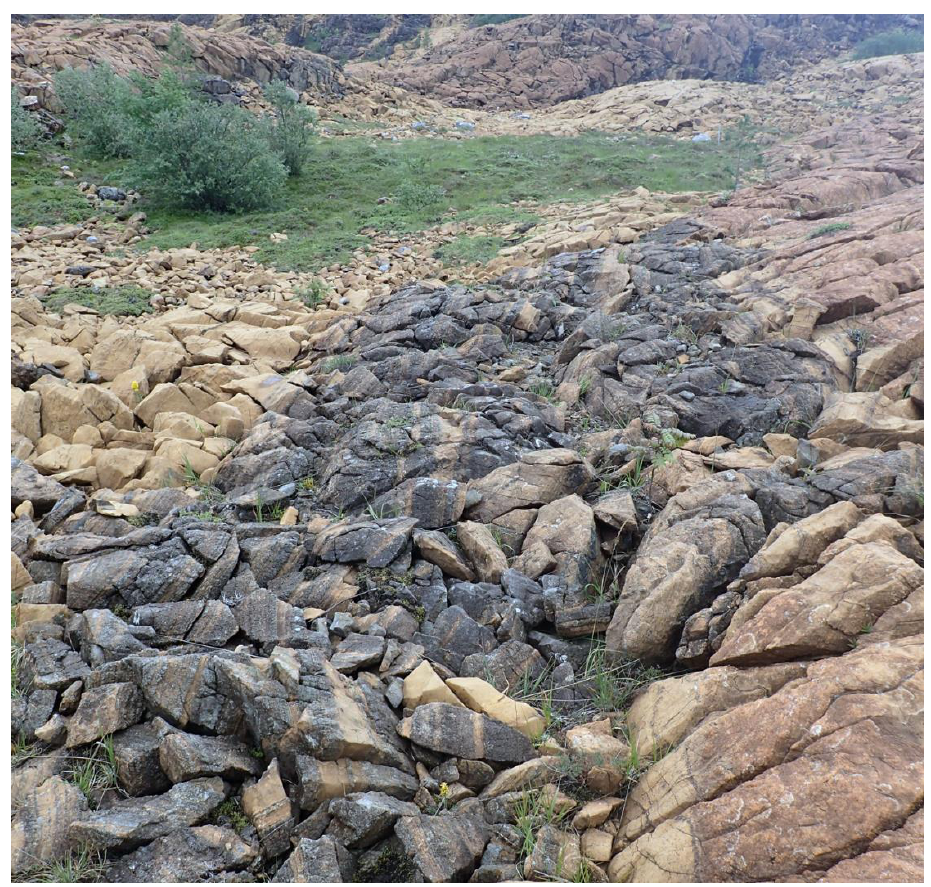
Figure 3. Rough exfoliation of chromite bands (dark rocks) and dunite (pale rocks) at the northeast (NE) end of Støypet valley 250 m from the island ring road on the access